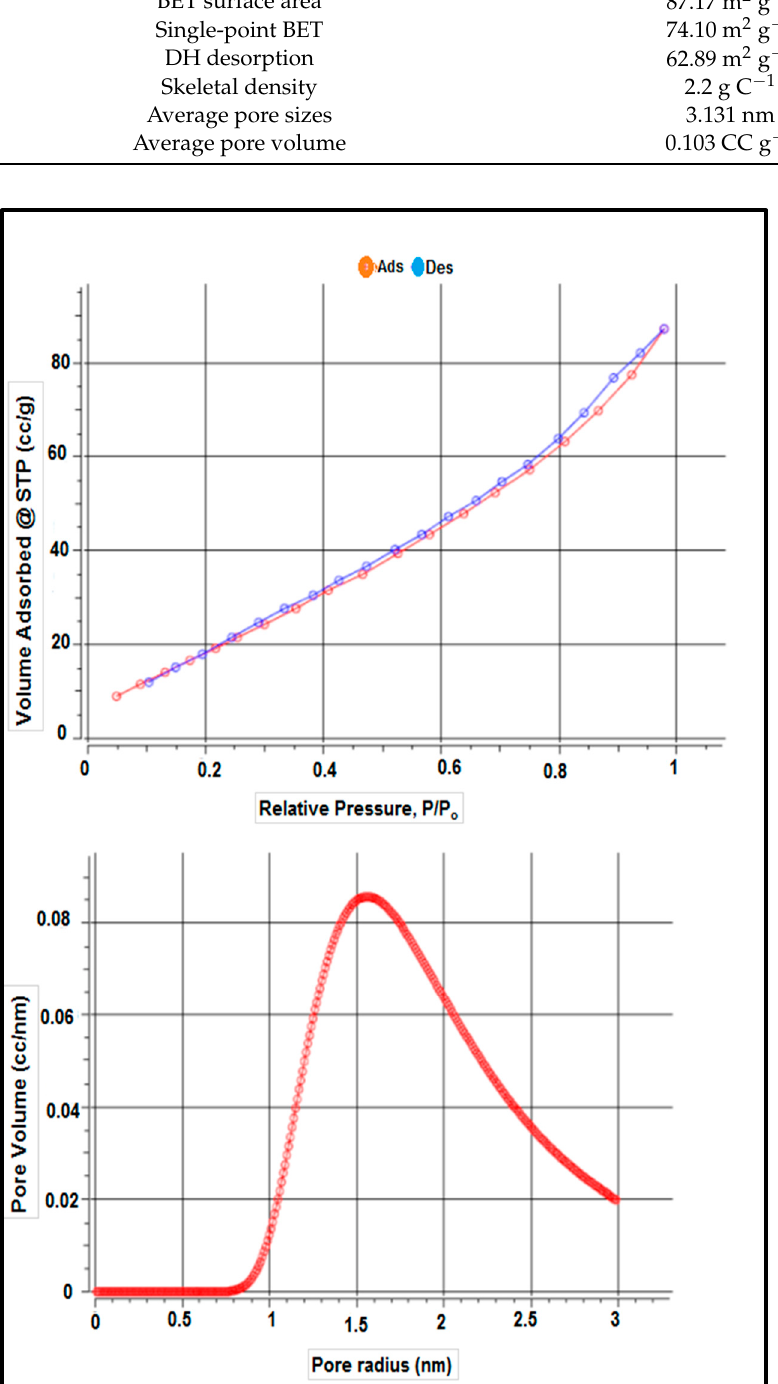
Figure 4. Isotherm–Isotherm isotherms and the pore size distribution.